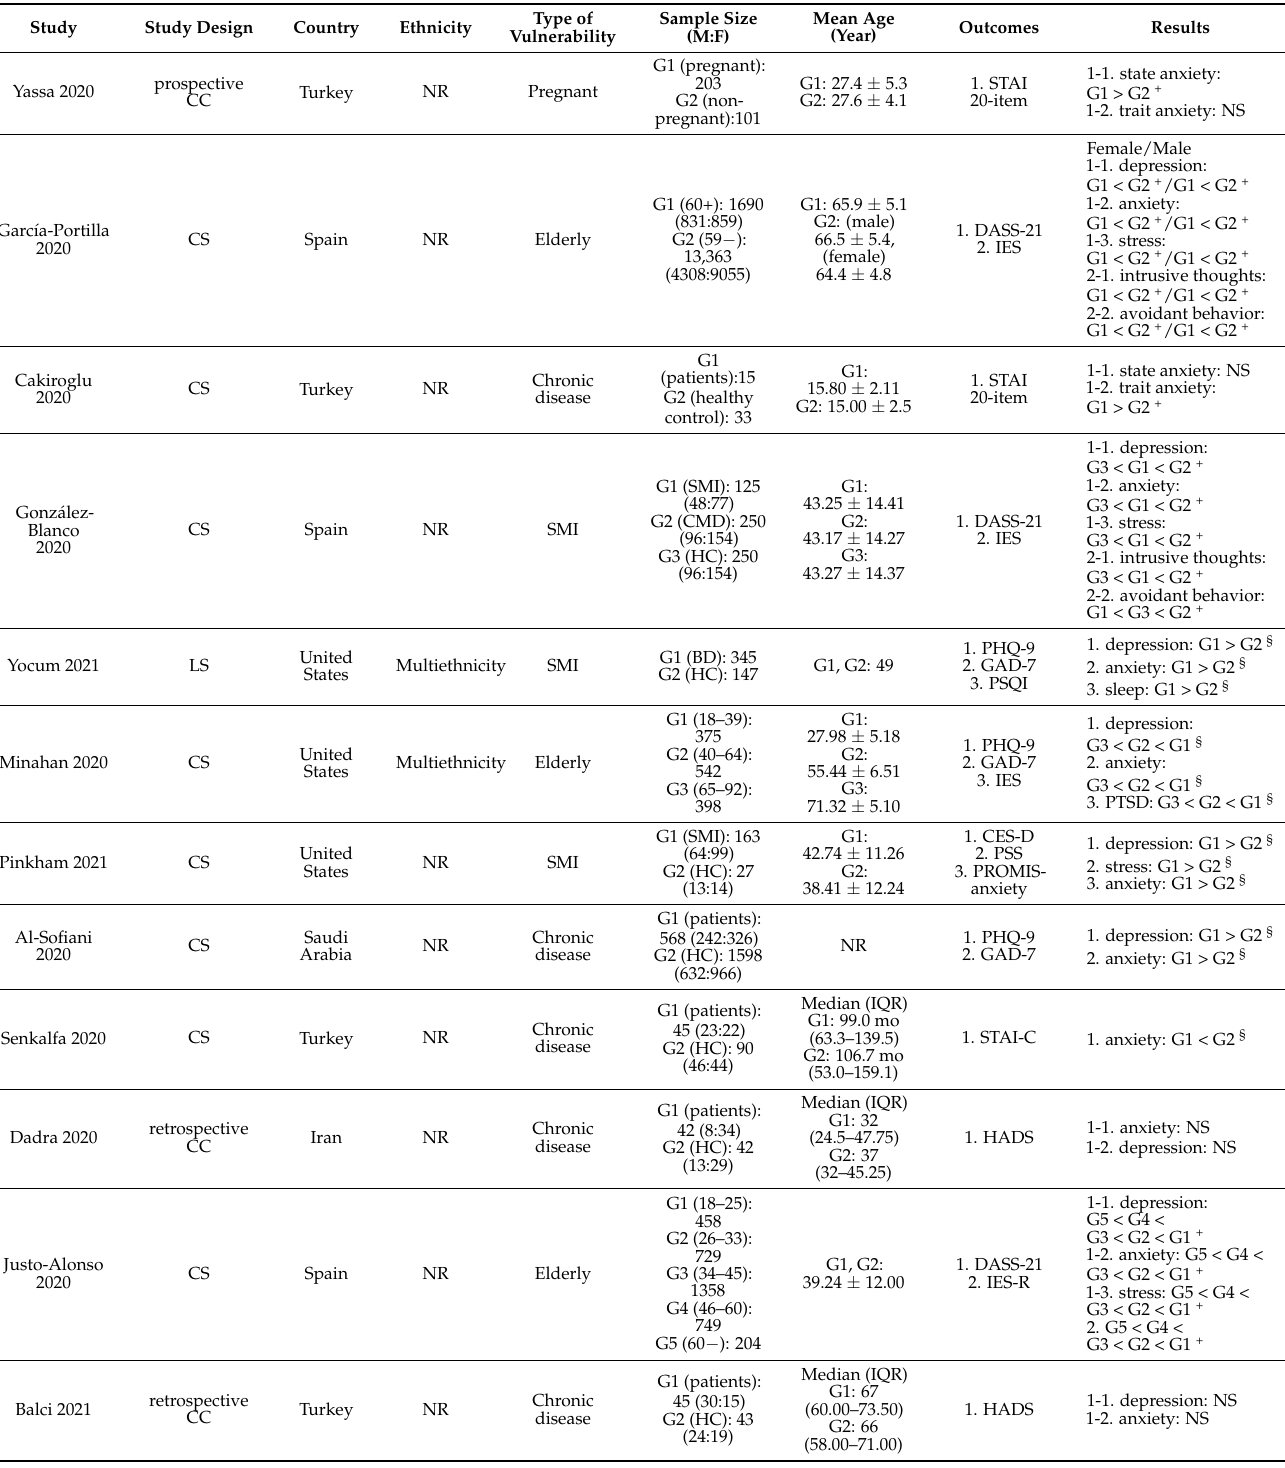
Table 1. Characteristics of included